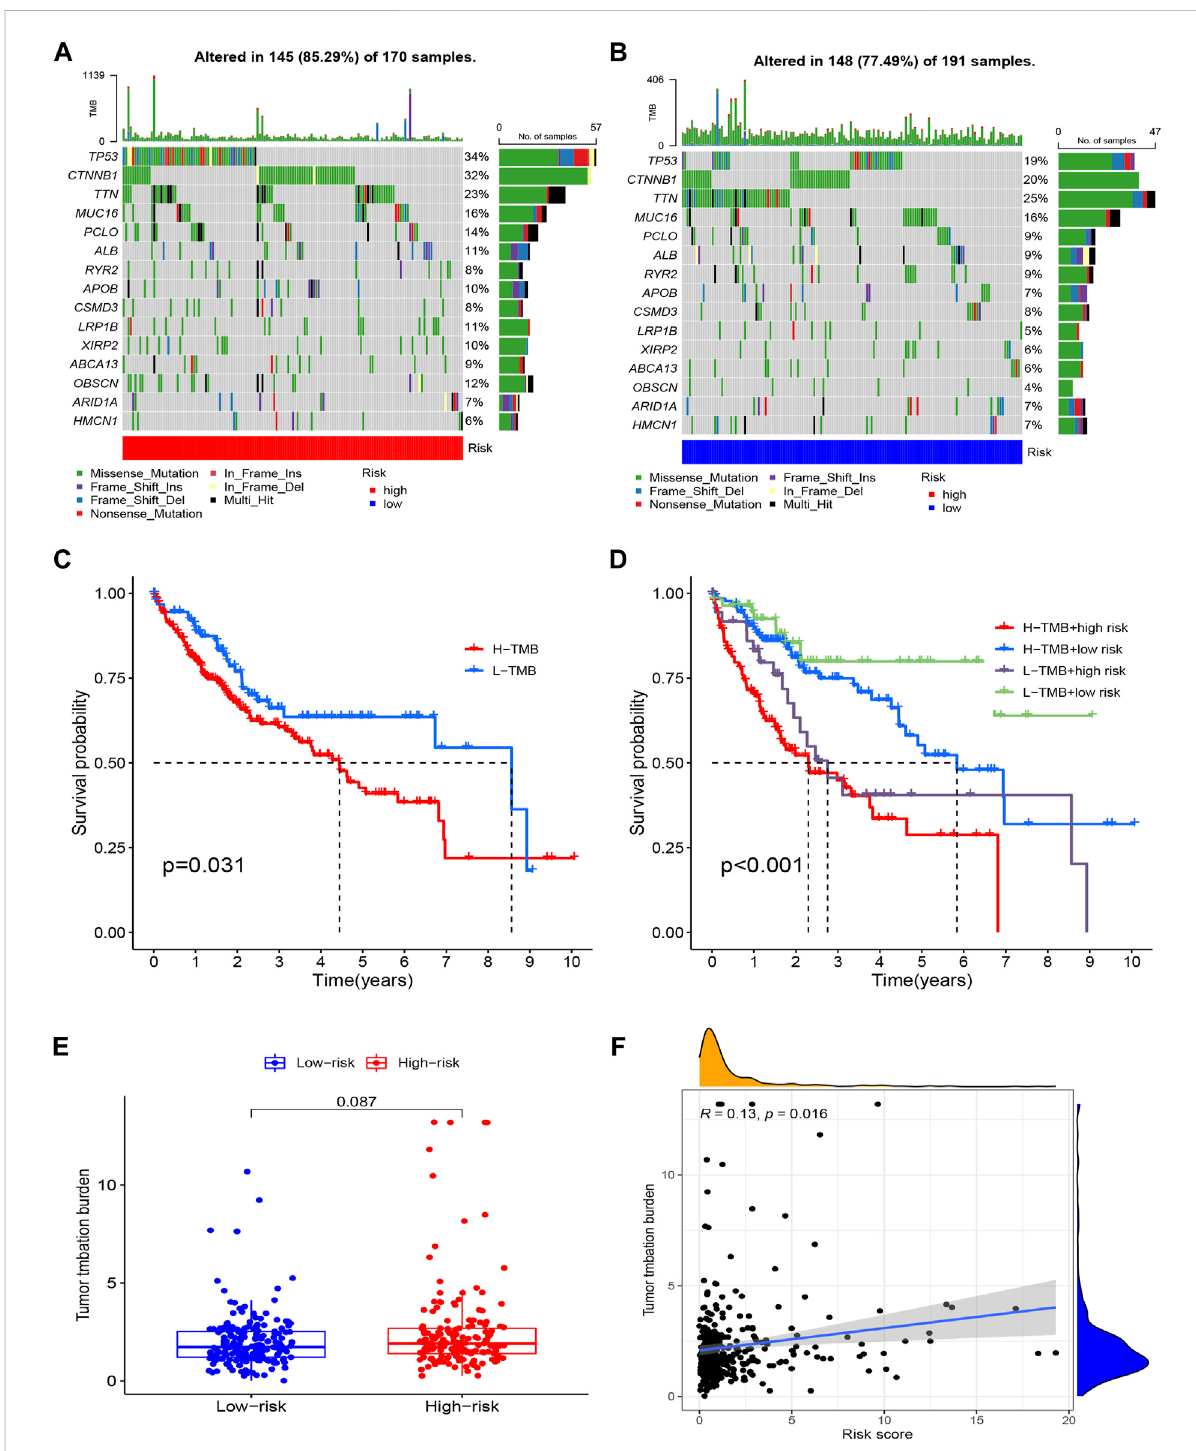
Tumor Mutation Burden Calculation Analysis in the risk groups. (A) Tumor somatic mutation waterfall graph in high-risk group; (B) Tumor somatic mutation waterfall graph in low-risk group; (C) Kaplan – Meier survival analyses of TMB with OS; (D) Kaplan – Meier survival analyses of TMB and risk group on OS; (E) The relationship between TMB and risk groups; (F) Correlation analysis of the risk score and tumor mutation